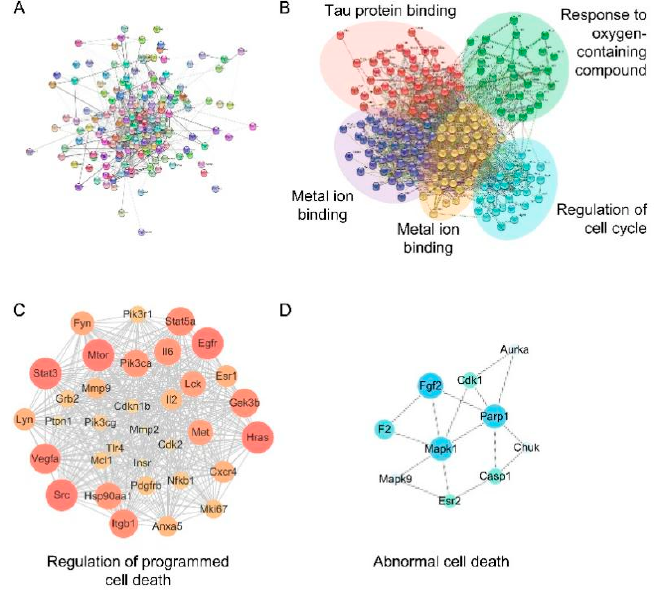
Figure 3. Network cluster analysis. ( A ) PPI network of 183 potential therapeutic targets. ( B ) Network cluster analysis. The main function of each cluster was identified by enrichment analysis. ( C , D ) High-scoring subnetworks and their major